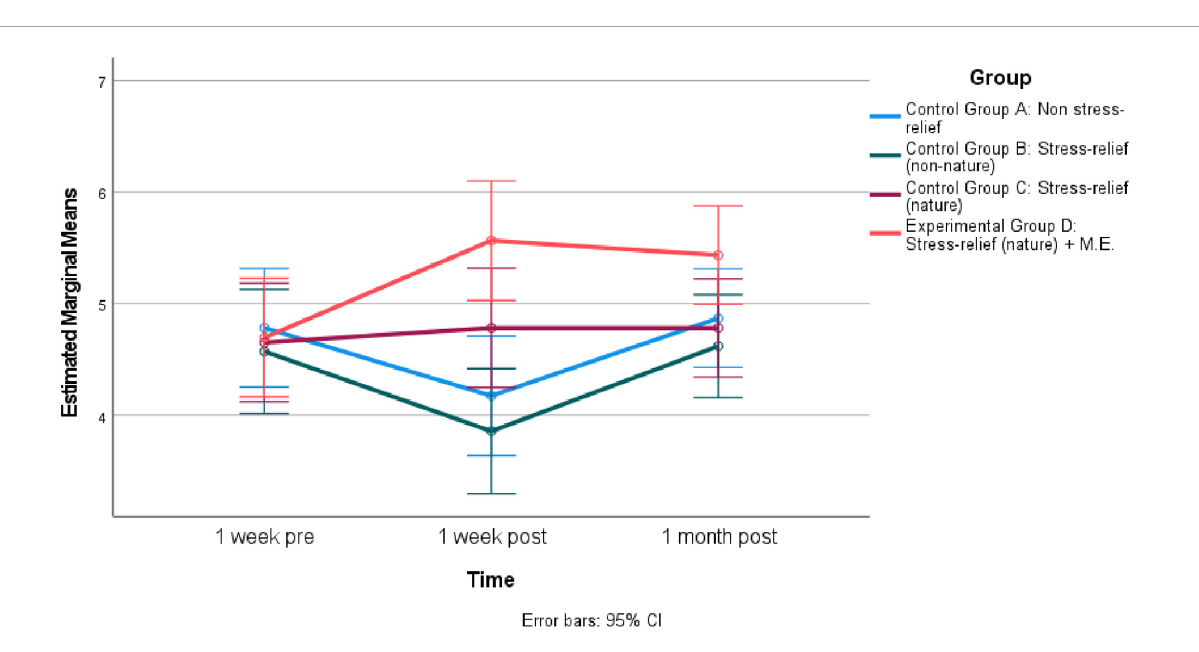
1 week and 1 month post,” no significant differences existed among the four